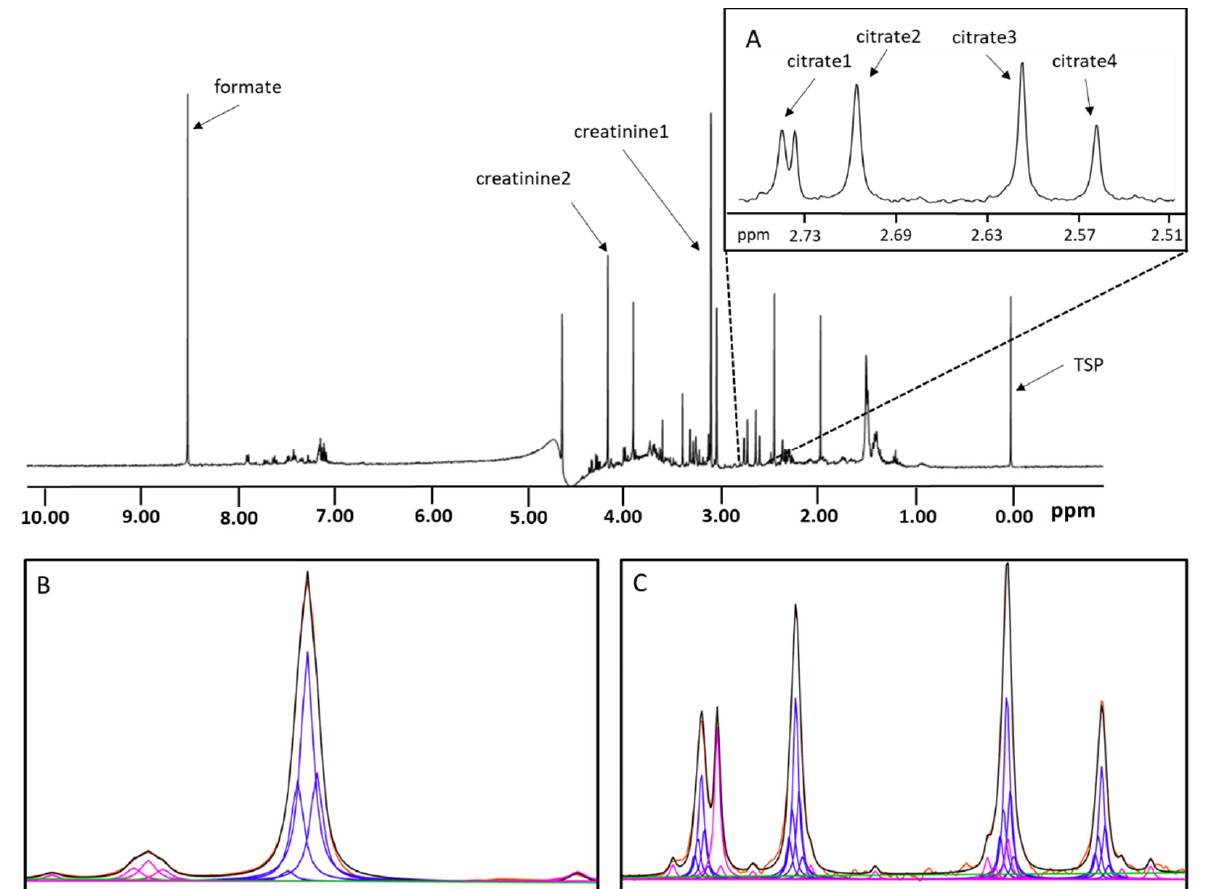
Figure 1. Representative 1D 1 H NMR spectrum for urine using a pulse-acquire experiment with WET solvent suppression. Resonance assignment for relevant signals are shown. ( A ): spectral expansion showing the four citrate signals. ( B ): Overlay of creatinine observed signal (red) and the mathematical model (black), along with analyte Lorentzian (blue), non-analyte Lorentzian (magenta) and linear baseline (green) components. ( C ): The citrate observed signals (red) are overlaid with the mathematical fit (black). The analyte Lorentzian lineshapes (blue), non-analyte Lorentzian lineshapes (magenta) and linear baseline (green) are also shown.